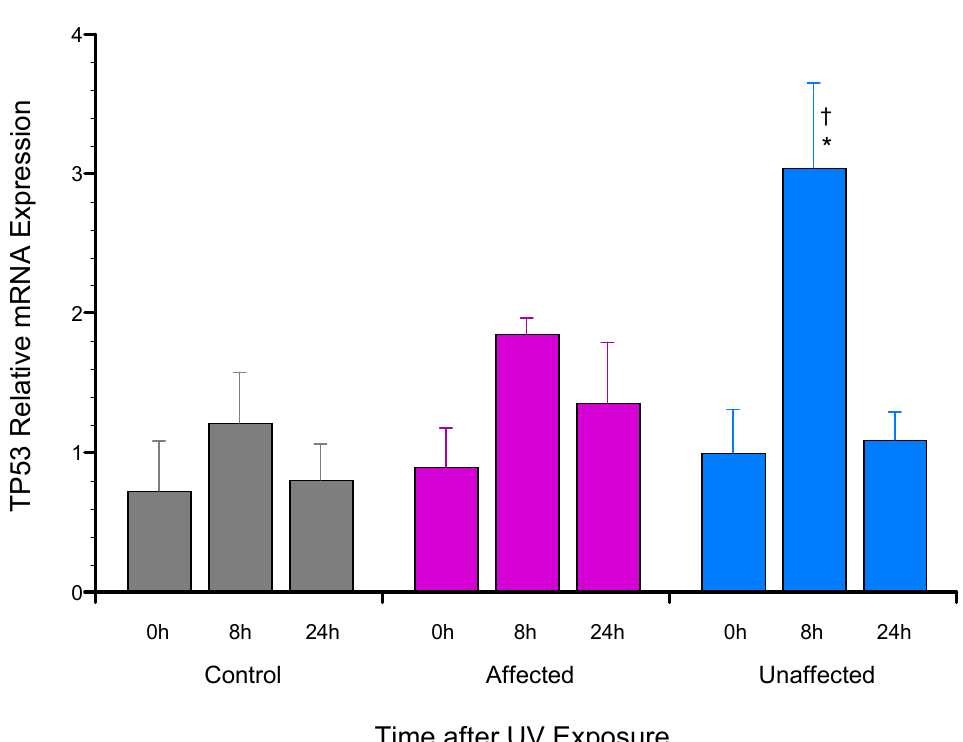
Figure 4. TP53 mRNA expression by dFb from unaffected compared to affected LFS or control subjects in response to UV exposure. Total dFb RNA was analyzed by RT-qPCR following UV irradiation, as described. Expression of TP53 mRNA normalized relative to HPRT1 mRNA was calculated based on ΔΔ C q values at each sample time point ( n = 4: * p < 0.05, affected vs. unaffected dFb; † p < 0.05, affected vs. control dFb).